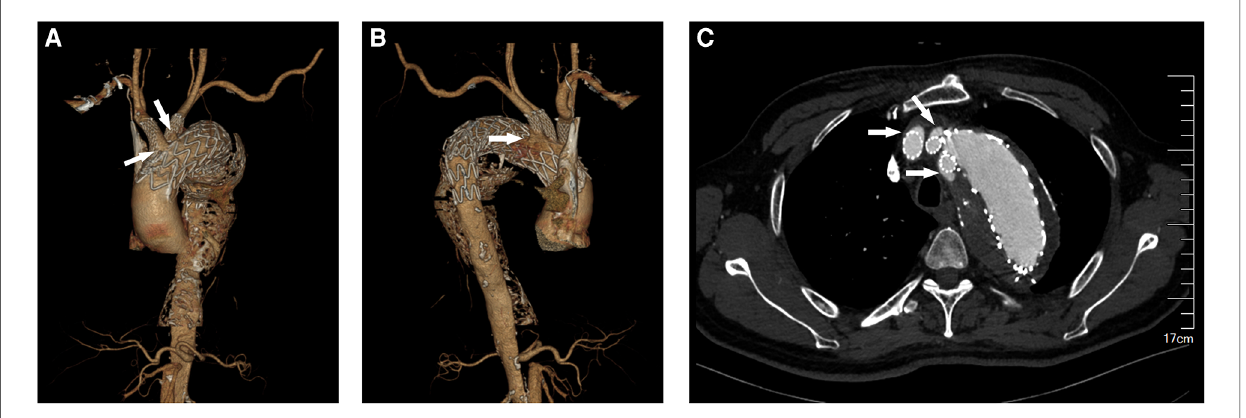
FIGURE 2 A 69-year-old male patient underwent fb-arch repair for a postdissection aortic arch aneurysm. Probably because of the large aortic arch diameter, there seems to be endoleaks around the reconstructed supra-aortic vessels during the follow-up. ( A ) The CTA imaging of the Type IIIc endoleaks near the brachiocephalic trunk and the left common carotid artery after fb-arch repair. (arrow). ( B ) The CTA imaging of the Type IIIc endoleak near the left subclavian artery after fb-arch repair. (arrow). ( C ) The cross-sectional image of the Type IIIc endoleaks (arrow).